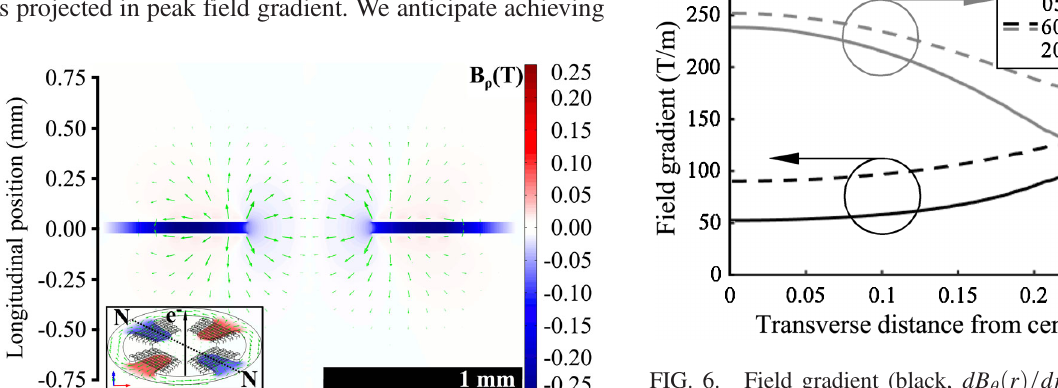
FIG. 6. Field gradient (black, dB θ ð r Þ =dr ) and effective mag- netic length (gray) as a function of distance from the quadrupole center, calculated using FEM simulations of the quadrupole magnetic field at 1 A. The pole tip is 0.3 mm from the center. The solid line shows the prototype 0.3-mm-radius 0.055-mm- yoke length quadrupole and the dashed line shows an optimized 0.3-mm-radius 0.2-mm-yoke length quadrupole. Integrated field gradient remains constant across the magnetic gap. Variation in field gradient and magnetic length become more severe when the yoke length is much shorter than the magnetic